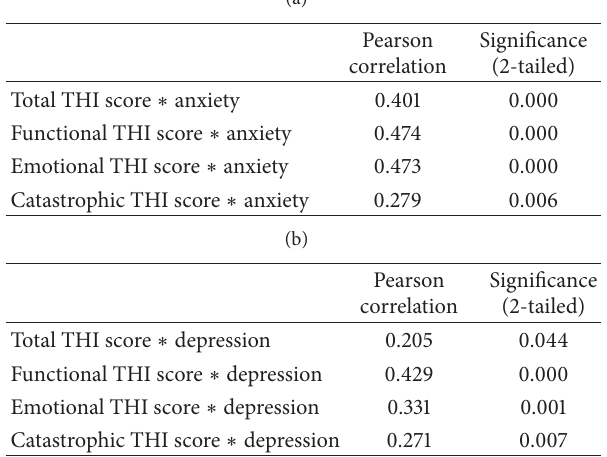
Table 2: (a) Correlations between the degree of tinnitus and anxiety. (b) Correlations between the degree of tinnitus and